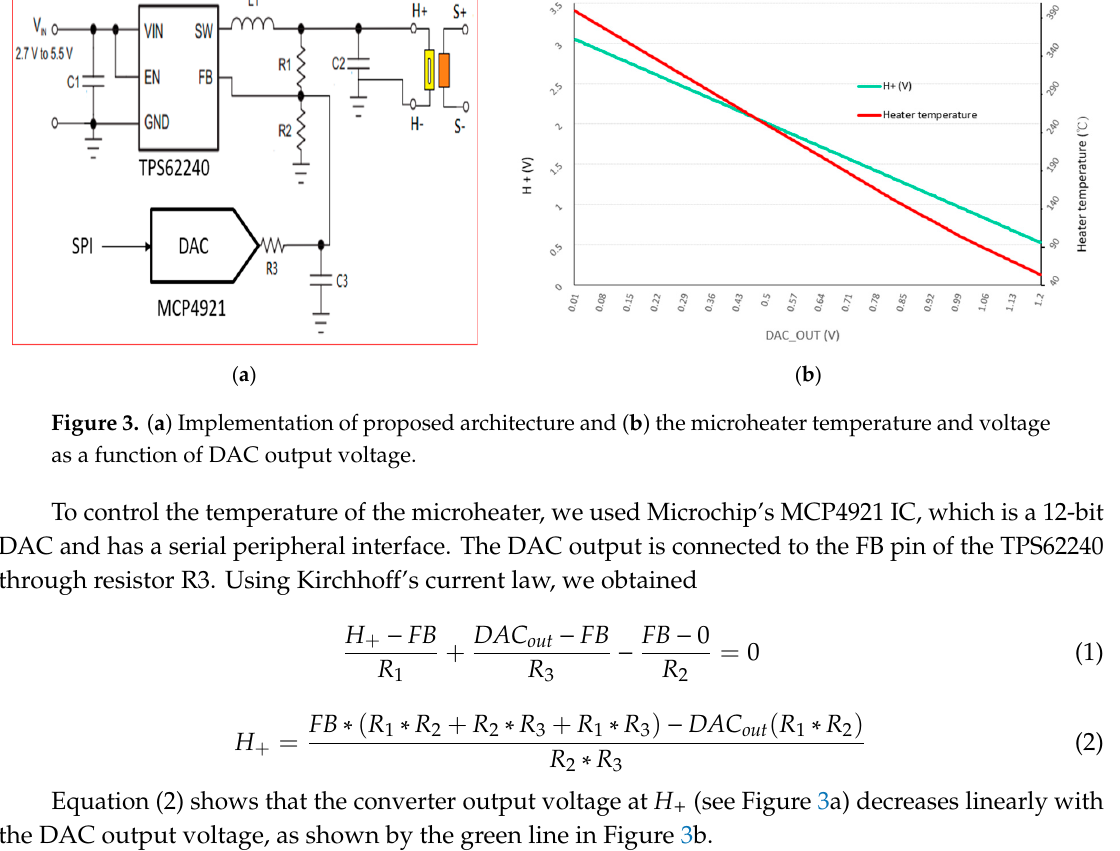
Figure 3. ( a ) Implementation of proposed architecture and ( b ) the microheater temperature and voltage as a function of DAC output voltage.